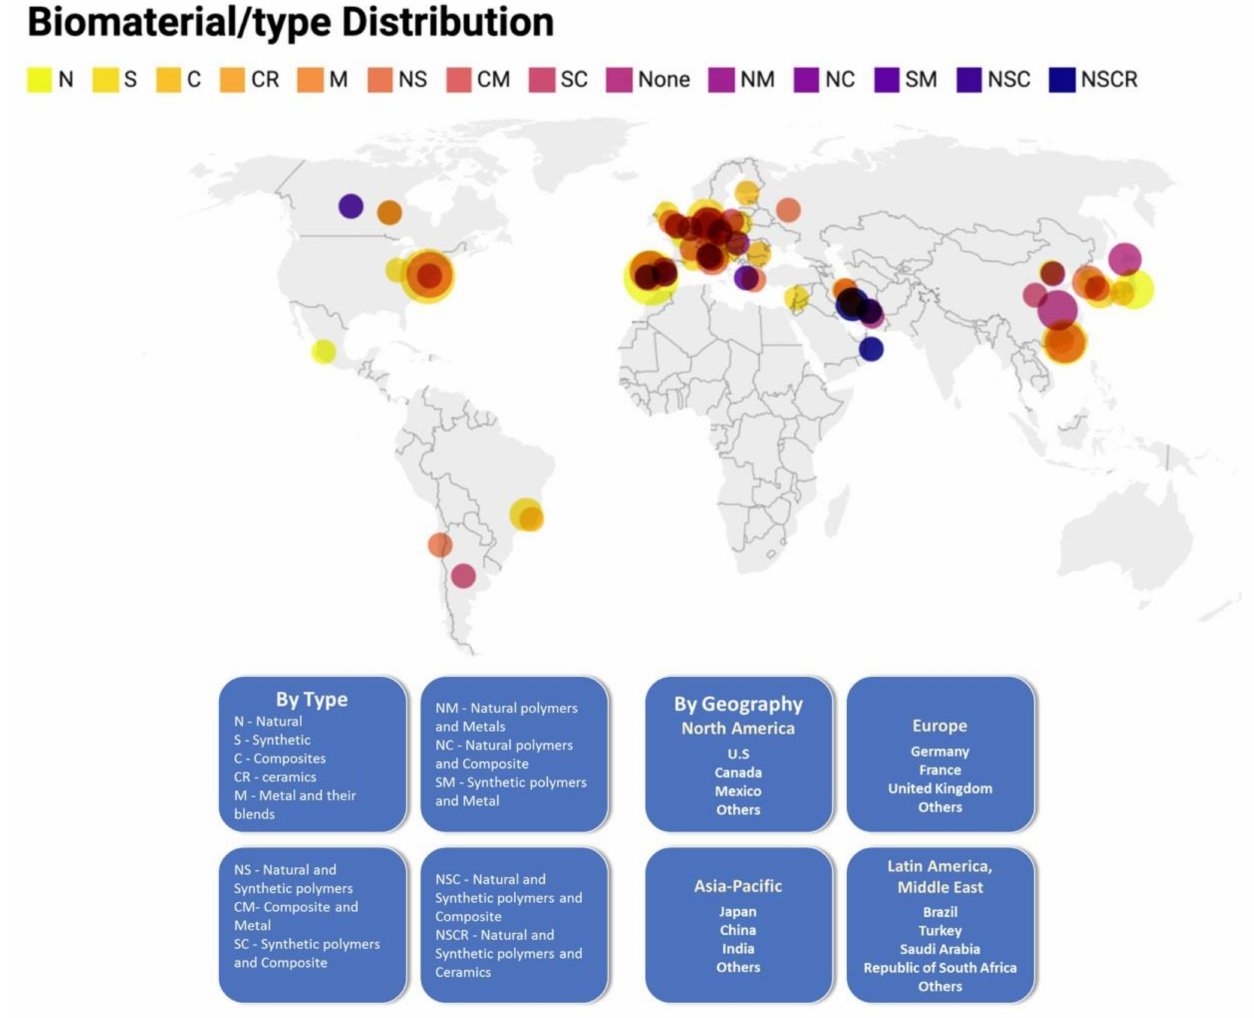
Figure 6. A bivariate dot distribution density map showing the relative type and concentration of the biomaterial used in each country (N, natural; S, synthetic; C, composites; CR, ceramics; M, metal and their blends—NS, natural and synthetic polymers; CM, composite and metal; SC, synthetic polymers and composite; NM, natural polymers and metals; NC, natural polymers and composite; SM, synthetic polymers and metal; NSC, natural and synthetic polymers and composite; NSCR, natural and synthetic polymers and ceramics). Biomaterial division map modified from Ratner B. et al., 2012, Biomaterial Science